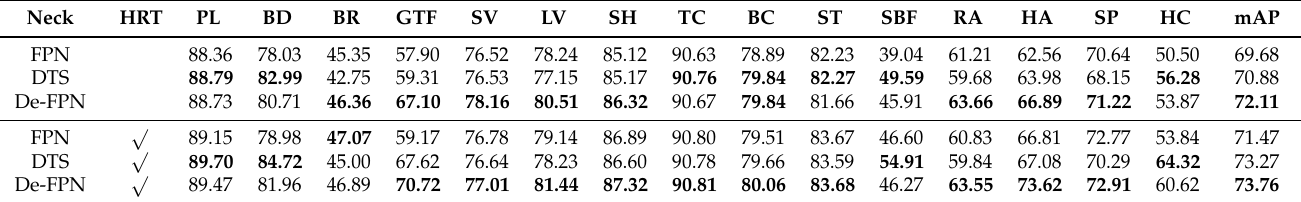
Table 1. Three kinds of necks are used to build arbitrary-oriented object detectors: Feature pyramid network (FPN), direct Top-down structure (DTS), and Deformable FPN(De-FPN). HRT denotes using High-Resolution crop during Testing. All models use ImageNet-pretrained ResNet50 as a